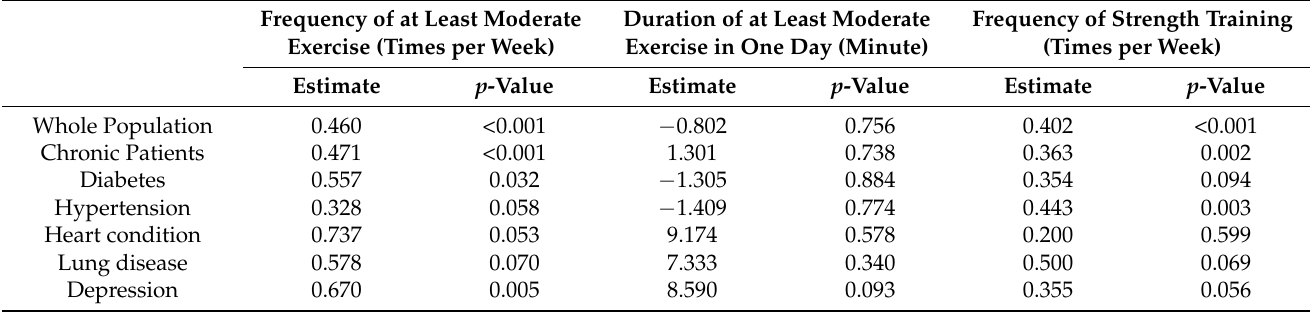
Table 2. Estimation results after matching (taking wearable device use as the independent